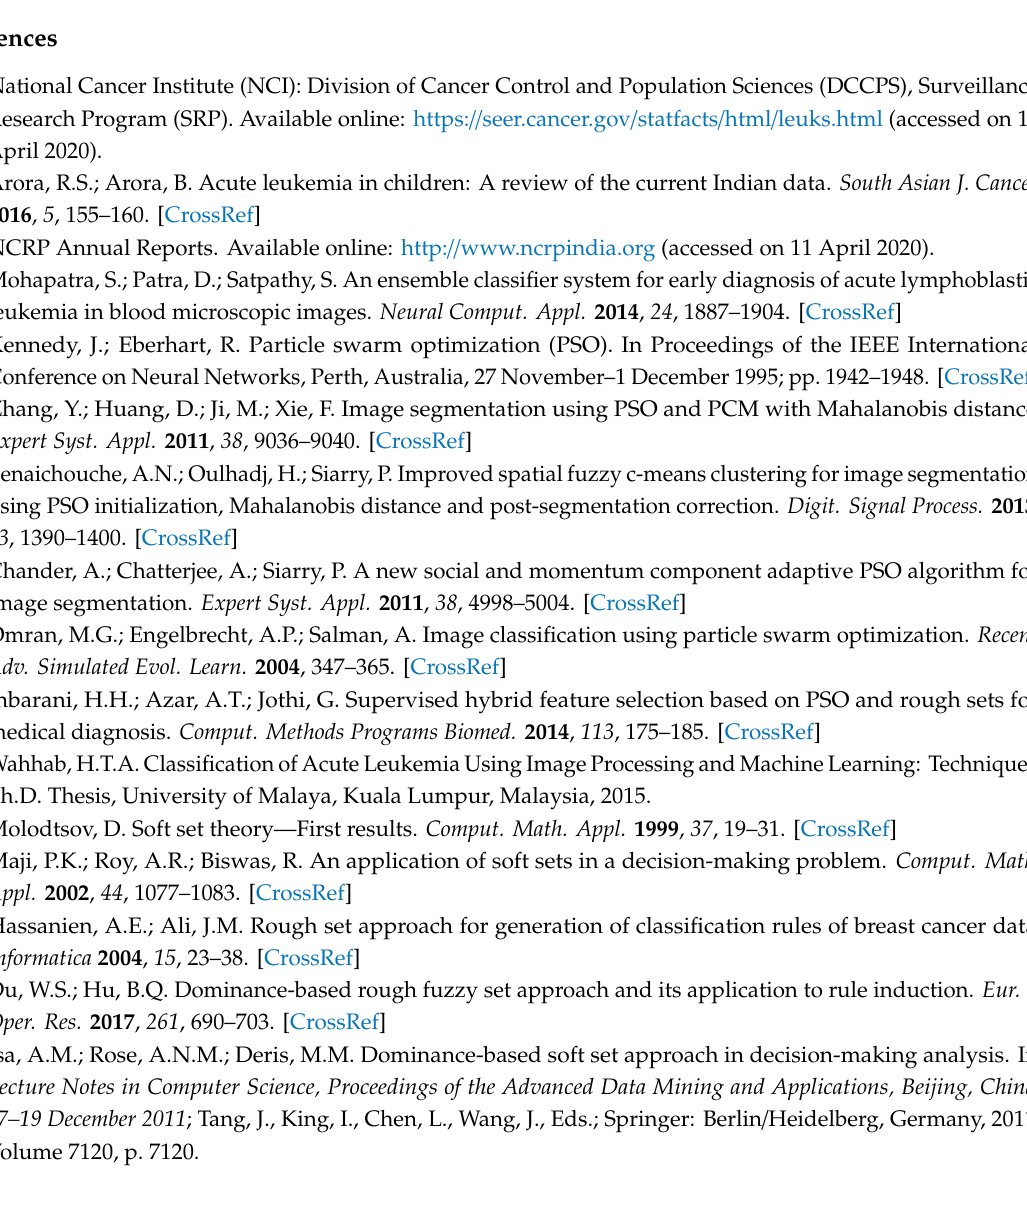
Figure A2. Pruned